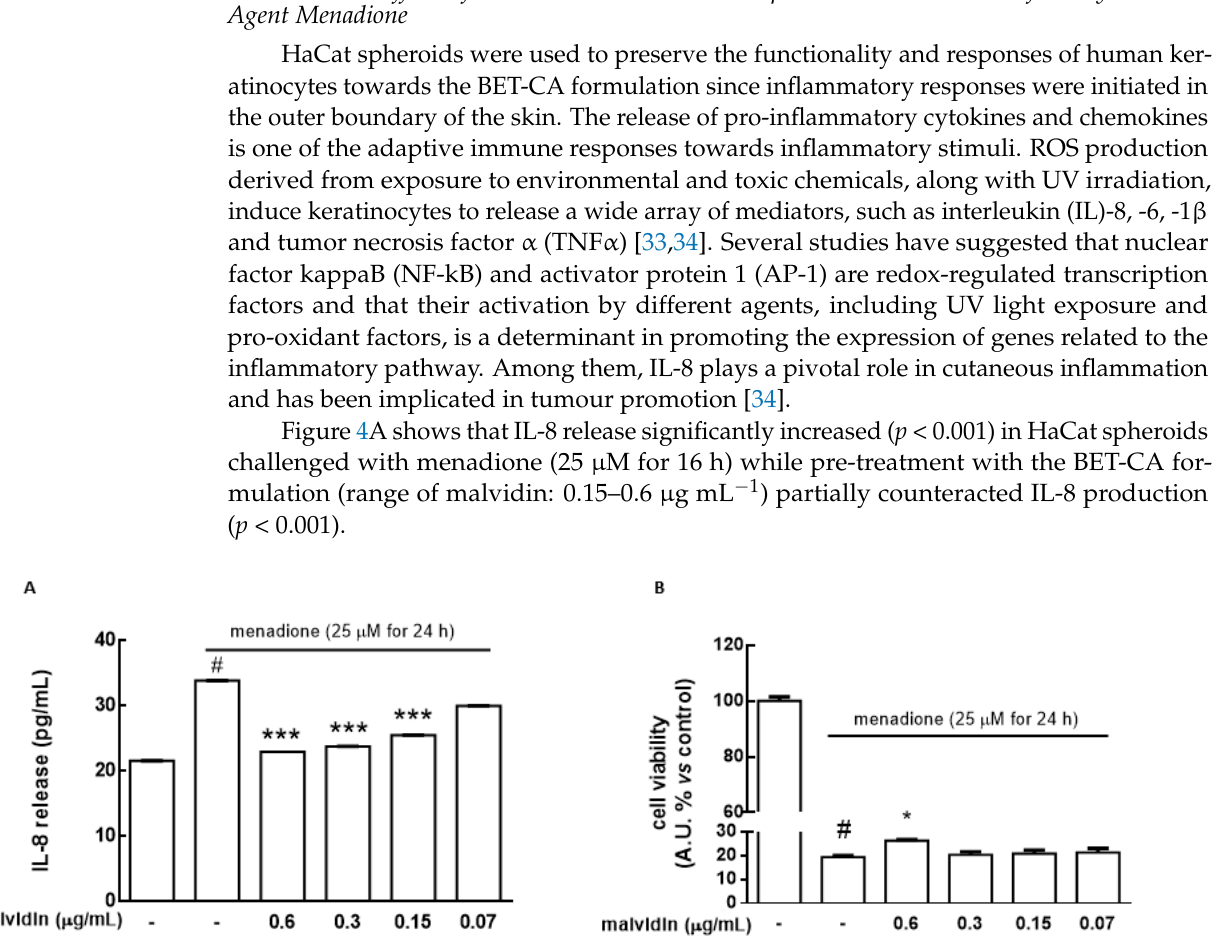
Figure 4. HaCat spheroids were treated with several dilutions of the BET-CA formulation (range of malvidin: 0.07–0.6 μ g mL − 1 ) for 24 h, including 16 h in the presence of menadione (25 μ M). ( A ) Release of the proinflammatory cytokine IL-8 (pg mL − 1 ) was determined by ELISA assay. ( B ) Cell viability was measured by cell counting kit 8, as described in the Materials and Methods section. Untreated HaCat spheroids served as a control (ctrl). Results are expressed as means ± SD of three independent experiments, each performed in triplicate. * p < 0.05, *** p < 0.001 significantly different from menadione treatment; # p < 0.001 significantly different from the ctrl.